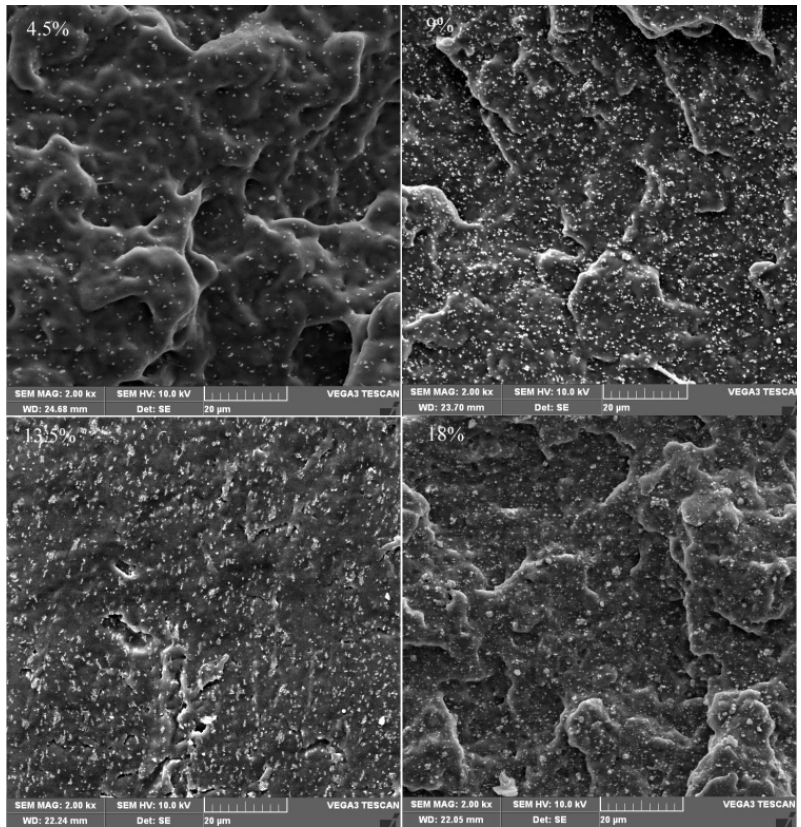
Figure 4. SEM of the Fe 3 O 4 /SBS/LLDPE composites.